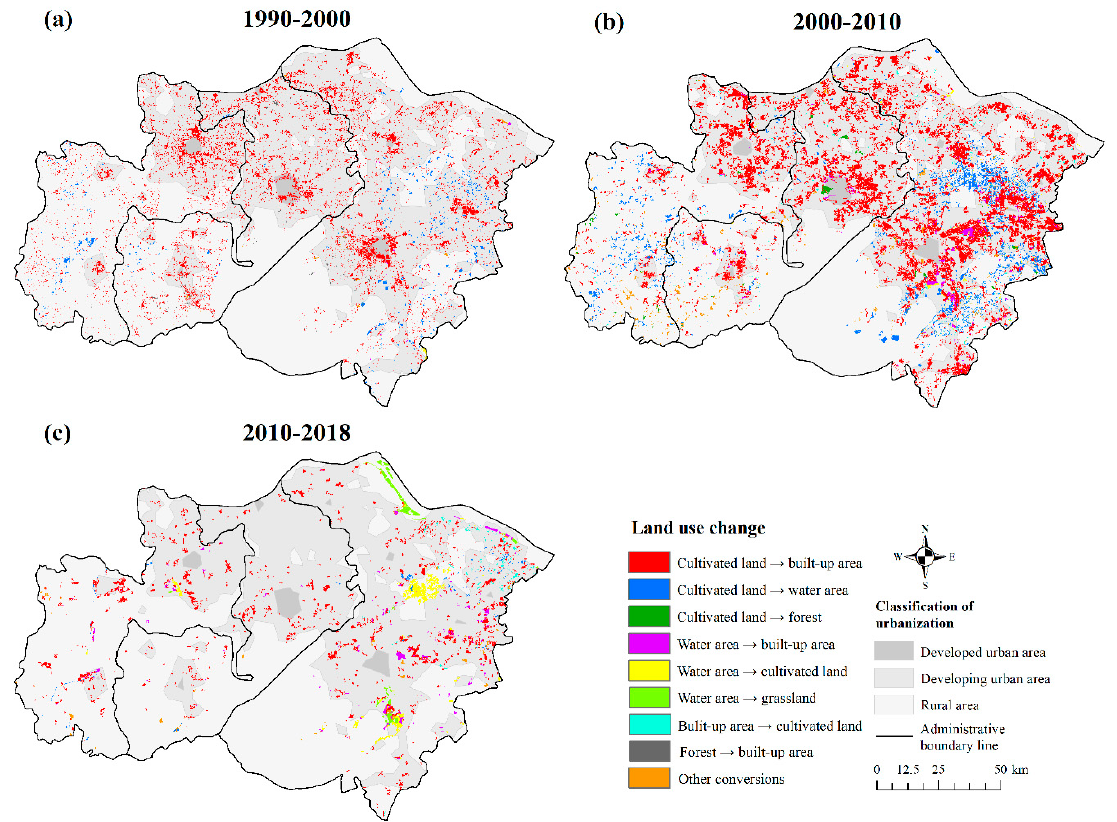
Figure 4. Spatial distribution of land-use changes from ( a ) 1990–2000, ( b ) 2000–2010, and ( c ) 2010–2018. Table 4. Transition matrix of land-use change during 1990–2000 (ha).